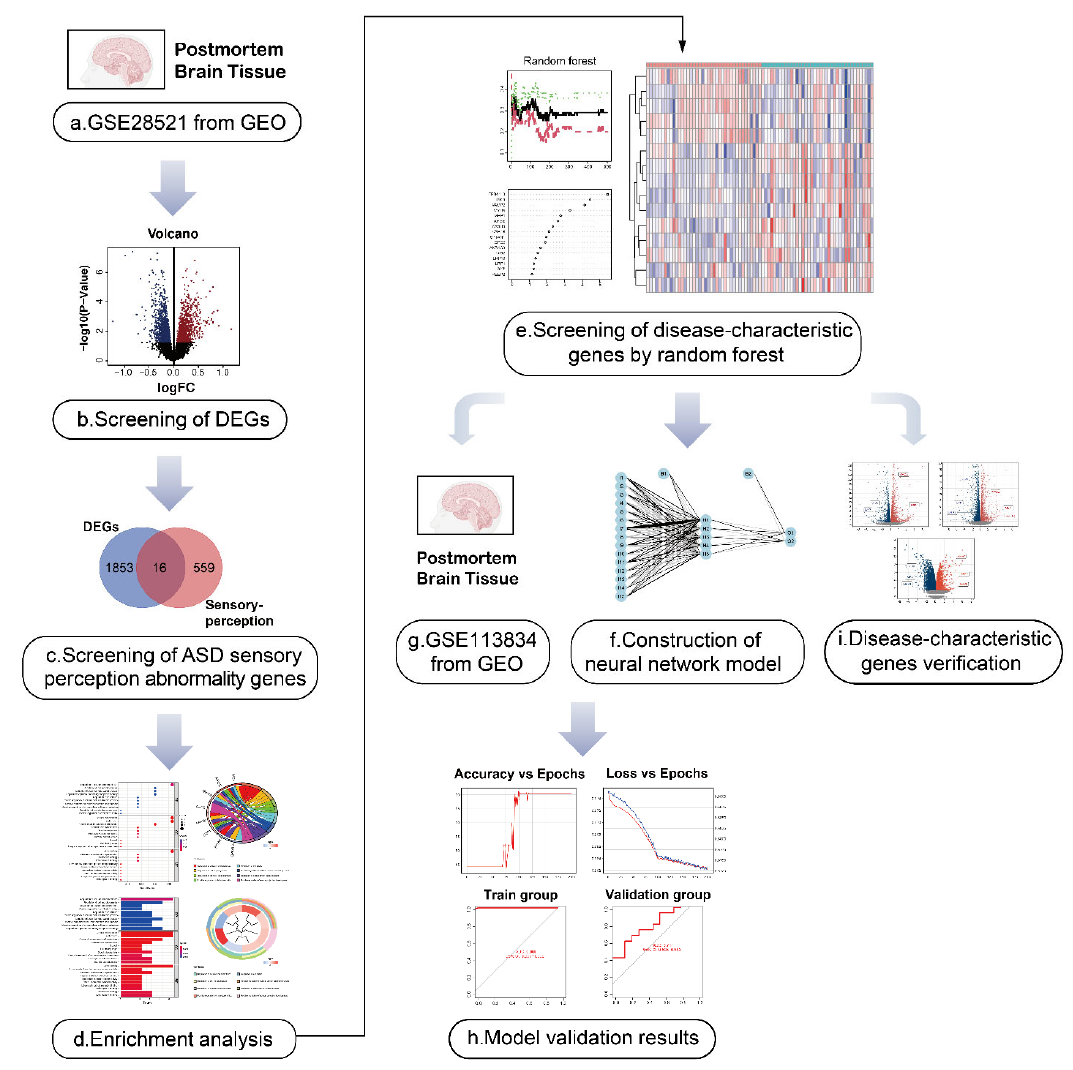
Figure 1. Flow diagram of the study. ( a , b ) The autism spectrum disorder (ASD) ‐ related dataset GSE28521 from human post ‐ mortem brain tissues containing 79 samples (40 Controls/39 ASD) was divided into an ASD group and the control group, and the differentially expressed genes (DEGs) in ASD were obtained by differential analysis. The volcano plot shows the up ‐ regulated and down ‐ regulated DEGs. I We took the intersection of ASD DEGs and the sensory perception gene set, and identified the genes associated with sensory perception abnormality in ASD. ( d ) Gene ontology (GO) and Kyoto Encyclopedia of Genes and Genomes (KEGG) enrichment analysis was performed for ASD sensory perception abnormality ‐ related genes to explore their biological function.( e ) The first 15 ASD sensory perception abnormality ‐ related genes were selected as disease ‐ characteristic genes by random forest analysis to construct the neural network model. ( f – h ) Neural network con ‐ struction: the GSE28521 dataset was used as the training set of the neural network model, and an ‐ other dataset GSE113834 (27 samples from post ‐ mortem brain tissues, 12 Controls/15 ASD) was used as the validation set. Finally, the area under the curve (AUC) of the model validation result was 0.711. ( i ) The data of the dorsal root ganglion (DRG), cerebral cortex and striatum from BTBR mice were used for the identification of DEGs. Nine genes ( MSN , APOE , CIB2 , LRP10 , LRP1 , SYP, MPP1, MYH9, and GPC2) were found among the DEGs, which were consistent with the disease ‐ character ‐ istic genes, verifying the accuracy of the model genes.